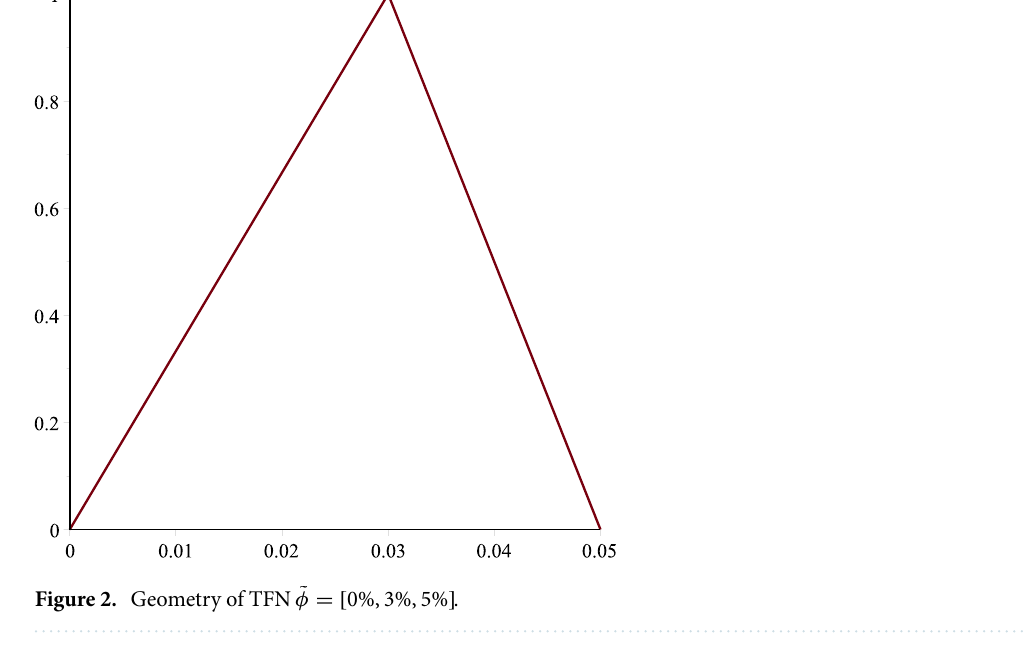
Figure 2. Geometry of TFN ˜ φ = [ 0%, 3%, 5% ] .